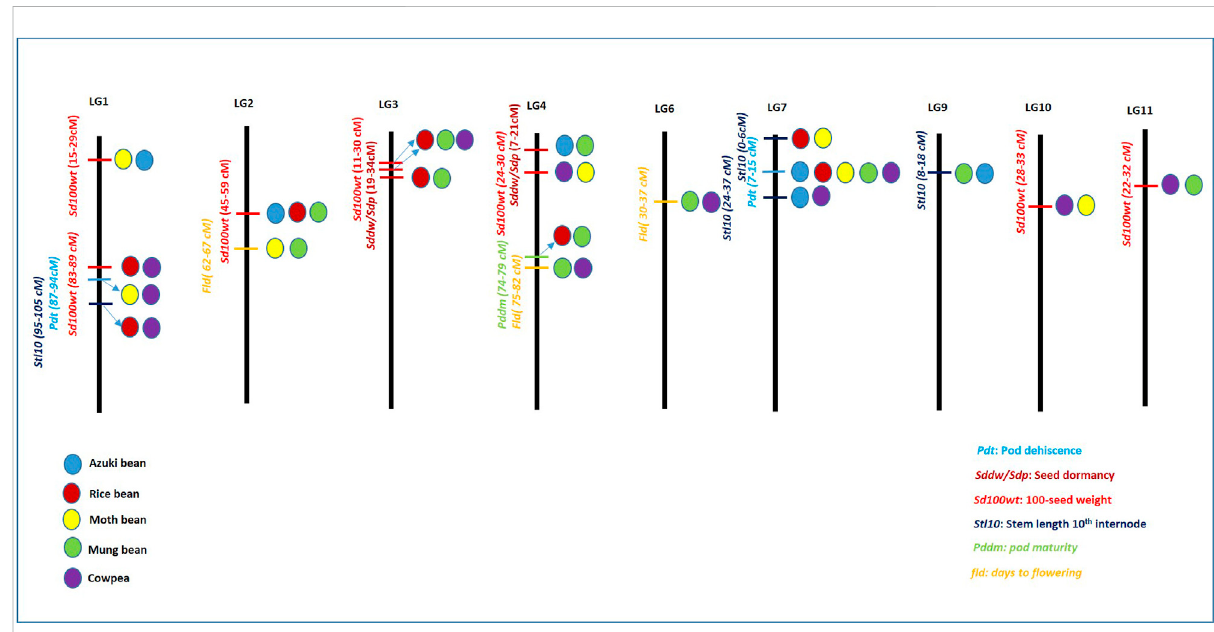
FIGURE 4 Pictographical representation of highly associated linkage groups along with common quantitative trait loci (QTLs) associated with domestication-related traits (DRTs) in Vigna . The length of linkage groups does not represent the scale. Differently colored circles differentiate different Vigna species. Blue: azuki bean, red: rice bean, yellow: moth bean, green: mung bean, and violet: